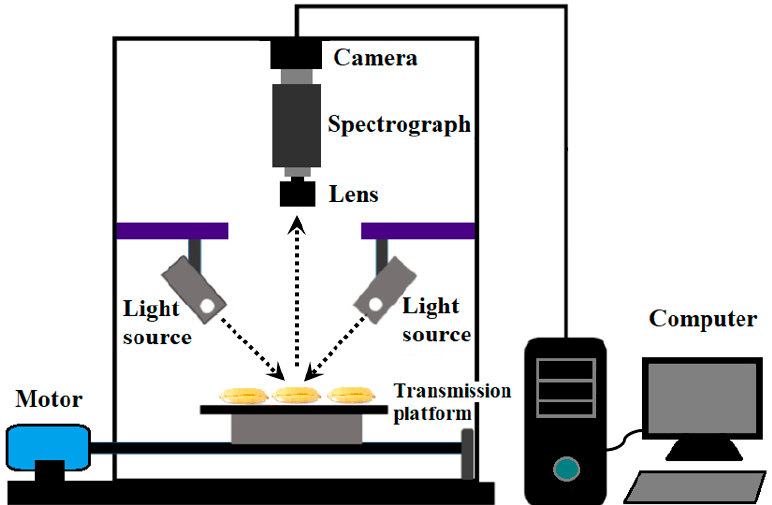
Figure 6. Schematic of line-scan near-infrared hyperspectral imaging (NIR-HSI) system and scanning of seed samples.